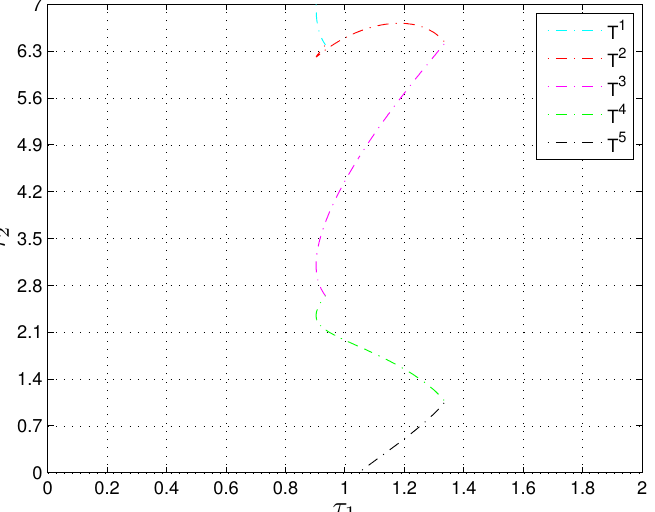
Figure 2. For r 1 = 1, r 2 = 0.1, a = 0.09, b = 0.2, c = 4, η = 0.8, δ = 0.5, T 1 − T 5 are stability crossing curves. The stable region is on the left of the stability crossing